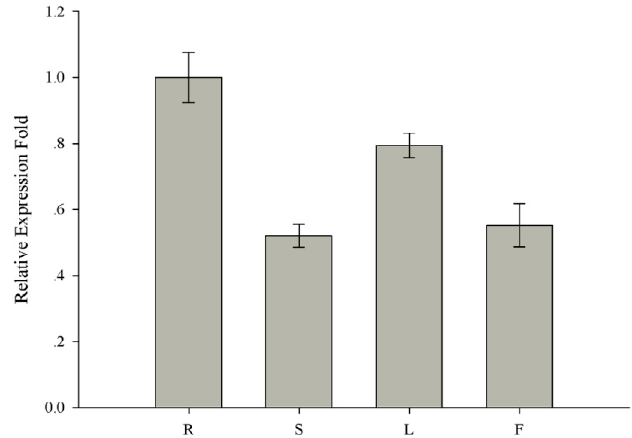
Figure 5. Expression profiles of GmMED16-1 in various soybean tissues. Expression of GmMED16-1 was detected in various soybean tissues under field grown conditions. Samples were collected in the flowering stages. The expression levels are normalized to GmCons4 gene as an endogenous control. R: roots, S: stems, L: leaves, F: flowers.